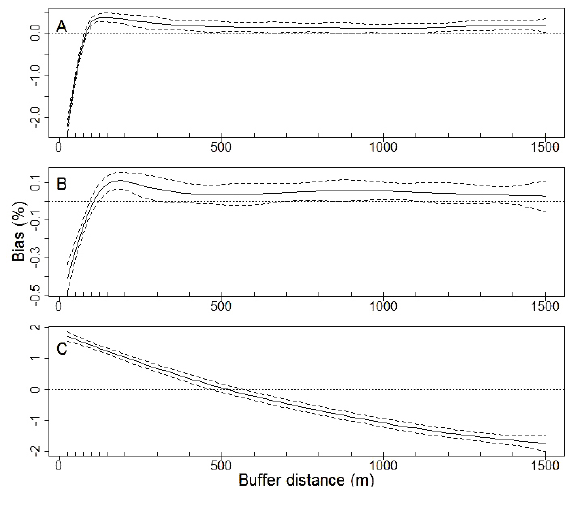
Fig. 2 . Generalized additive model results of the relationship between distance and the bias in representation of (A) forest “loss,” (B) forest fires, and (C) anthropogenic disturbance between North American Breeding Bird Survey routes and degree blocks. Mean predicted bias (solid line) and 95% confidence intervals (dashed lines) are